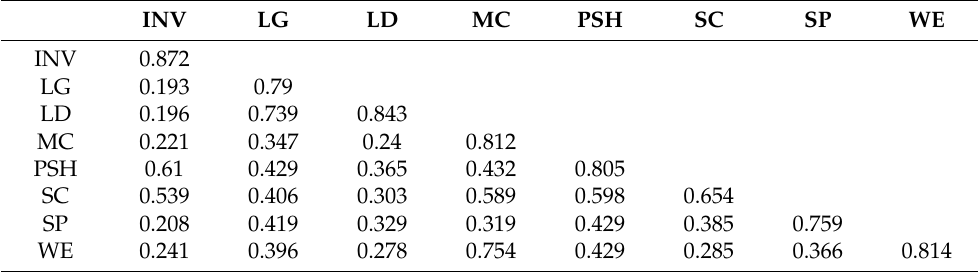
Table 6. Discriminant validity